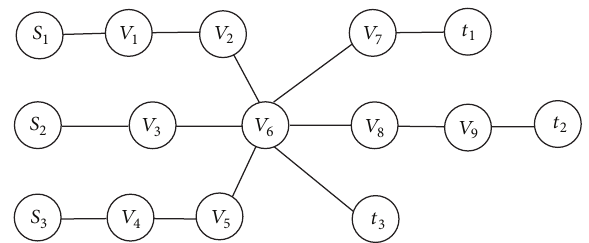
Figure 1: An example of a star tree for the SPIUH-ST